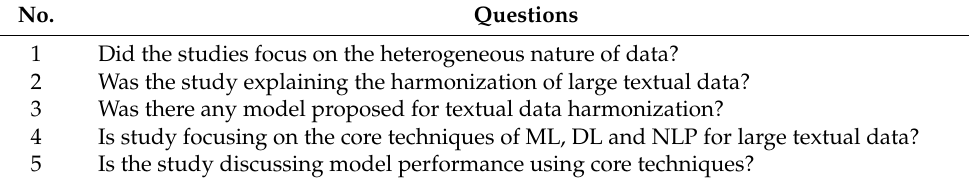
Figure 2. Process of identifying relevant studies. Table 3. Quality checklist.